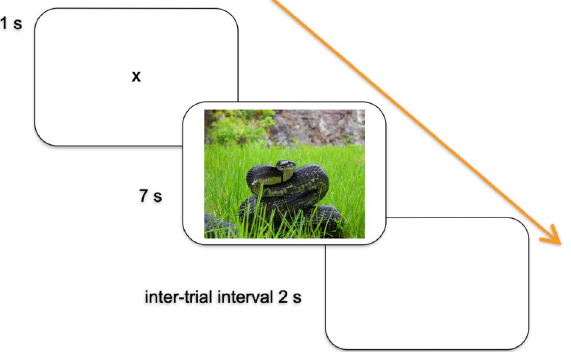
Figure 1. Example of a single experimental trial. The picture originates from the Open Affective Standardized Image Set 92 and serves only as an